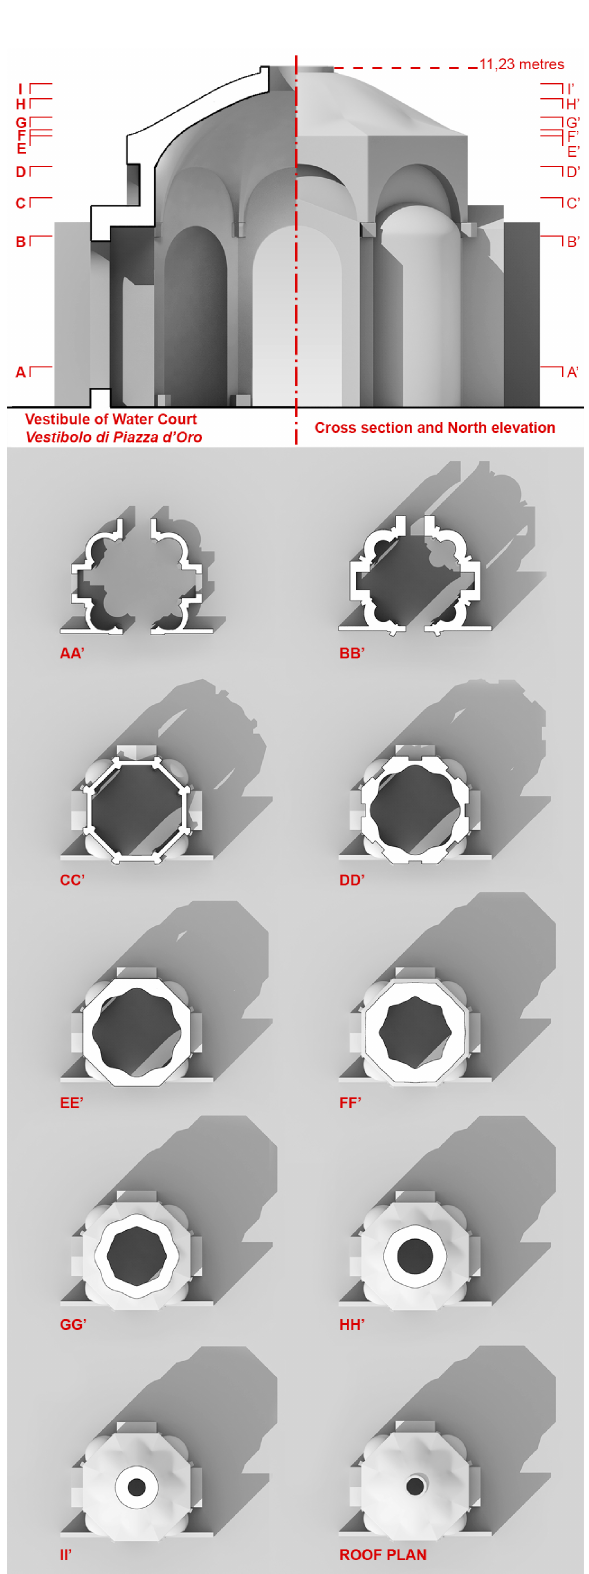
Figure 3. Vestibule of the Water Court. Rendering images of subsequent horizontal sections of the 3D procedural model of the